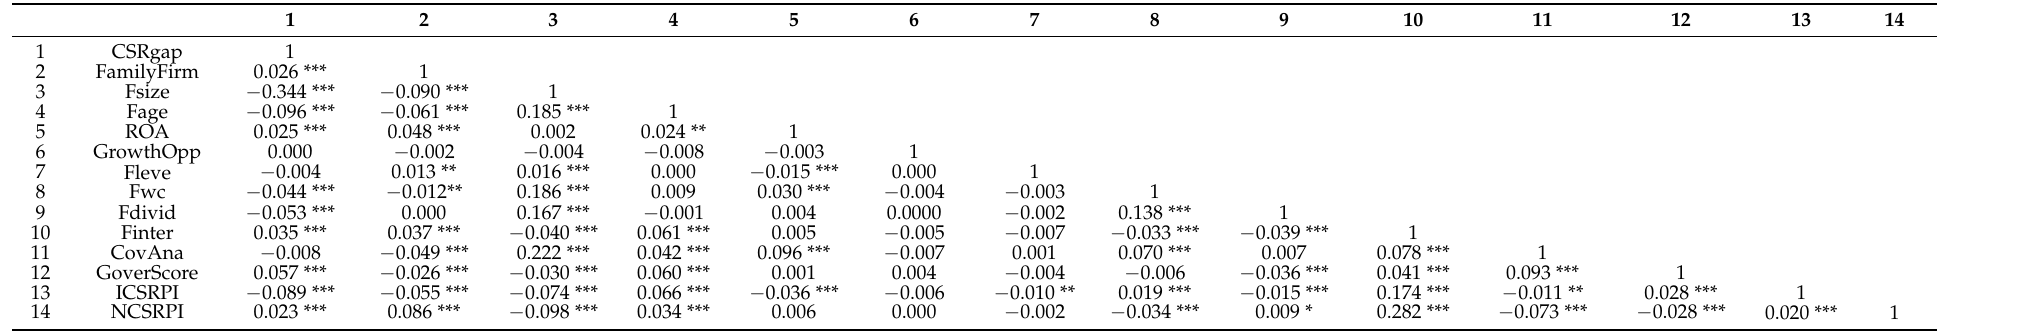
Table 3. Bivariate correlations (*** p < 0.01, ** p < 0.05, * p <